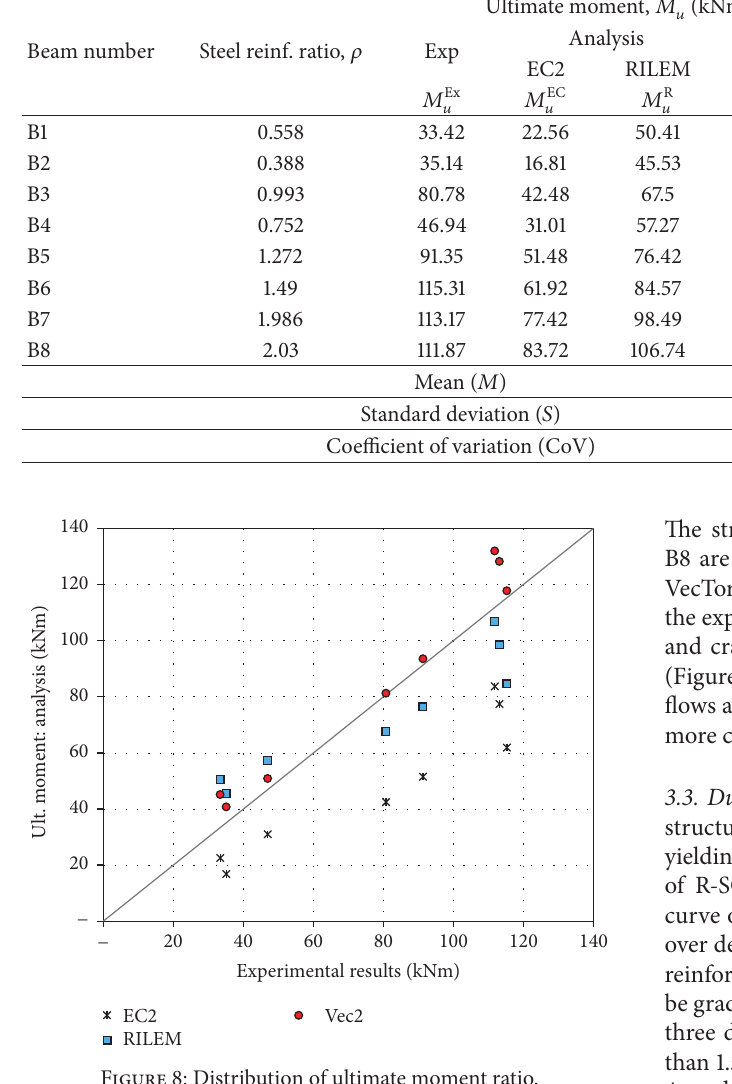
Figure 8: Distribution of ultimate moment ratio. Table 7: Cracks width for R-SC-ECC beams at service load. Beam